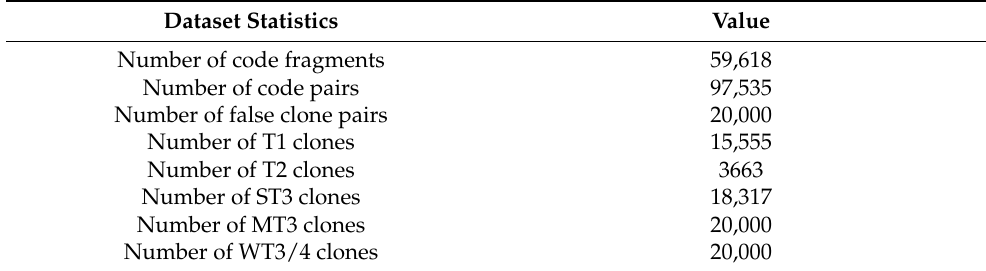
Table 1. BigCloneBench